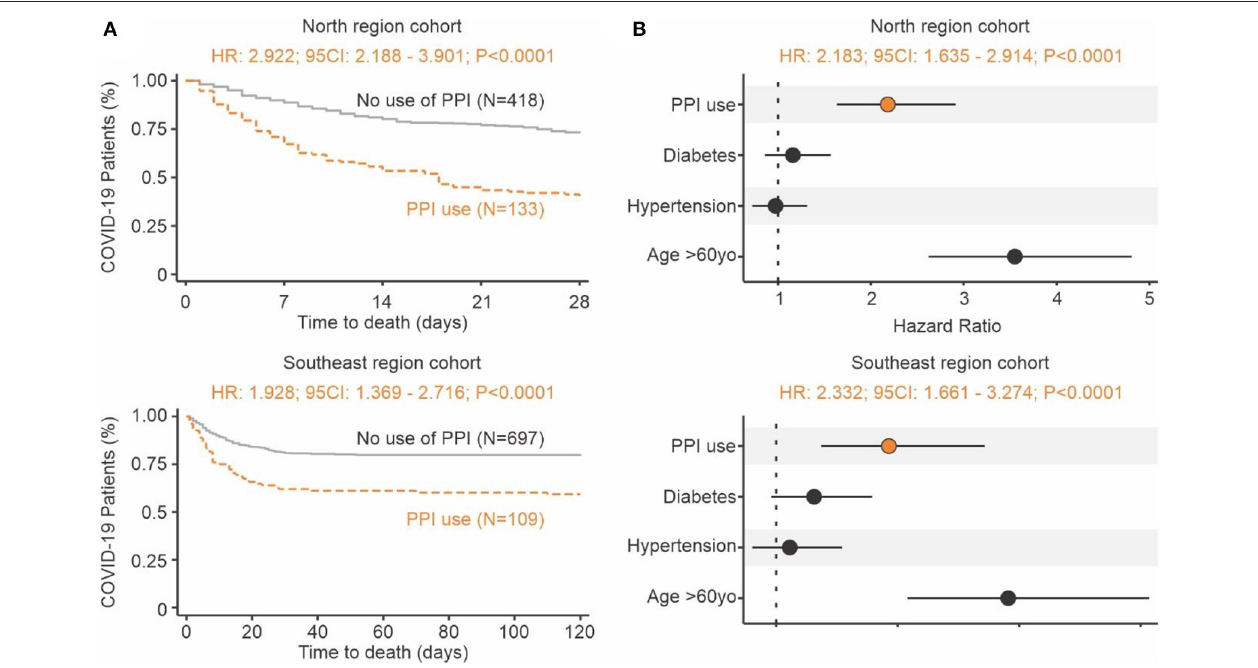
FIGURE 4 | Increase risk of death in individuals with COVID-19 using proton pump inhibitors prior infection. (A) Time to death. Kaplan-Meier survival curves showing a higher risk of death for the group of patients that used PPIs (brown) prior to admittance when compared to those not using them (gray). The North region cohort result is shown at the top and Southeast region cohort result is shown at the bottom. (B) Risk of death. The forest plot presents the hazard ratios and respective 95CI for the main explanatory variable (brown), as well as the potential confounders (black) used in the multivariate model. The North region cohort result is shown at the top and Southeast region cohort result is shown at the